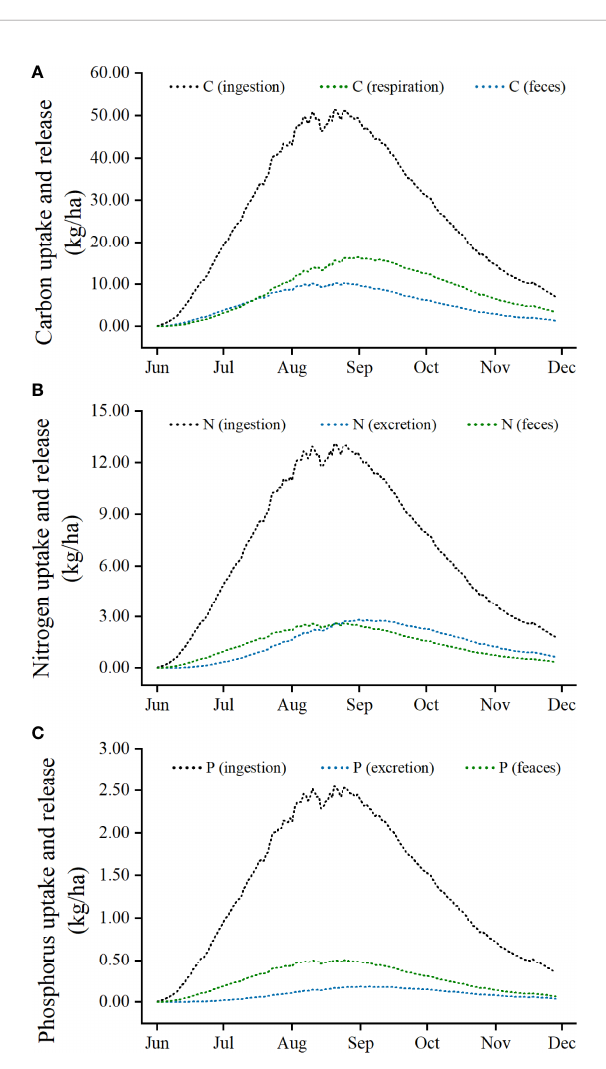
FIGURE 2 | Simulation of carbon (A) , nitrogen (B) , and phosphorus (C) dynamics associated with Portunus trituberculatus